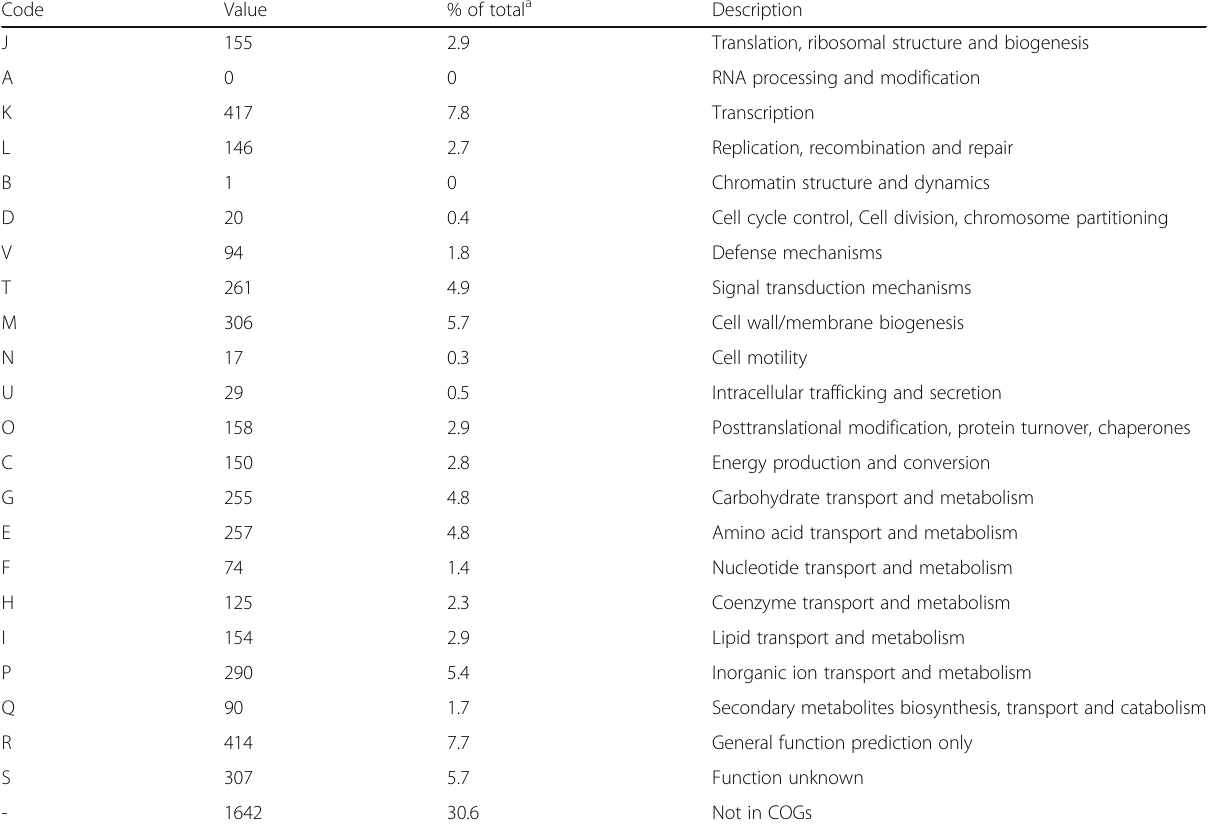
Table 4 Number of genes of Pedobacter steynii DX4 with the general COG functional categories Code